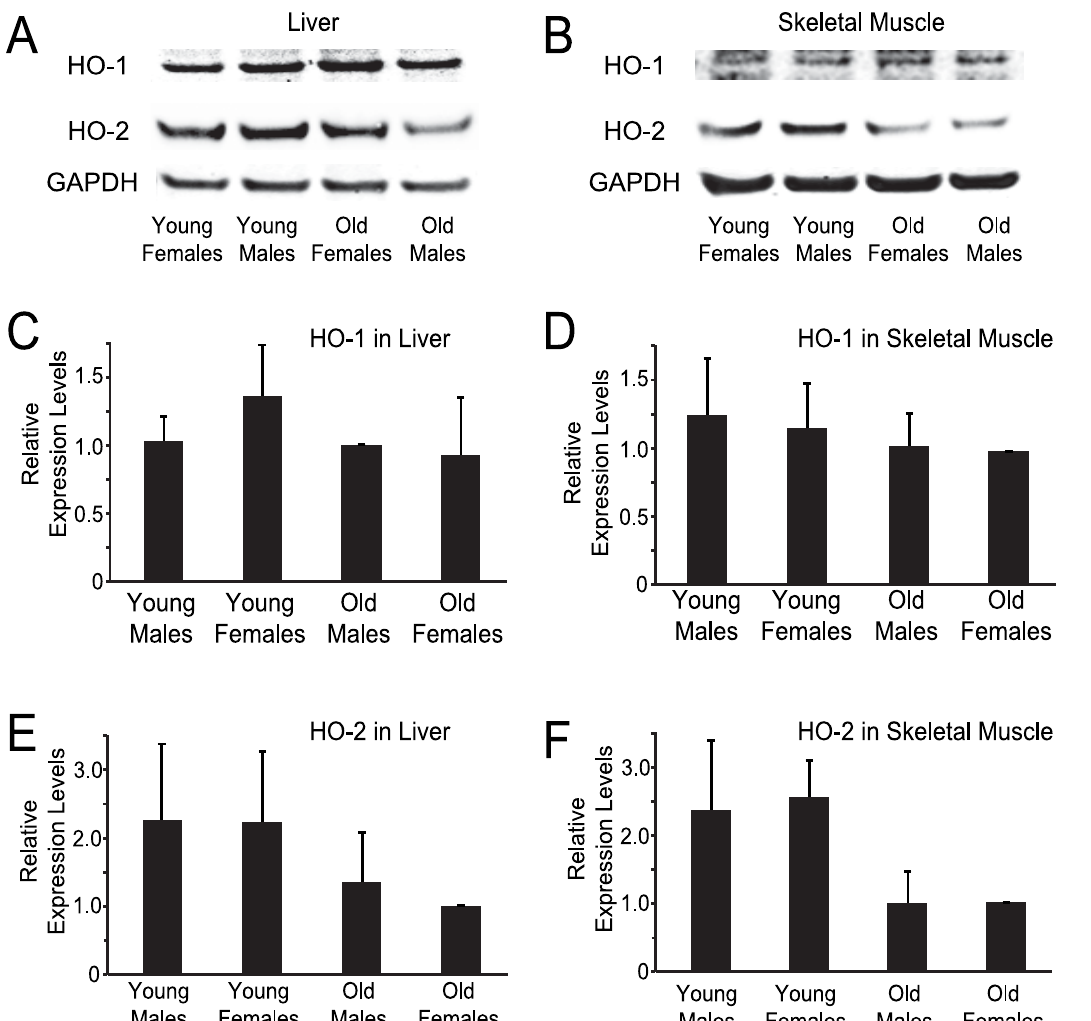
Fig 4. Age and gender analysis of HO-1/2 expression levels in liver and skeletal muscle. A - B , western blots for HO-1/2 and GAPDH in the liver and skeletal muscle, respectively, of young and old adult mice for both sexes. C and E , D and F , average relative western blot band intensities for HO-1/2 in liver and skeletal muscle tissue, respectively. Averages are from 3 independent trials for each age and gender in both liver and muscle